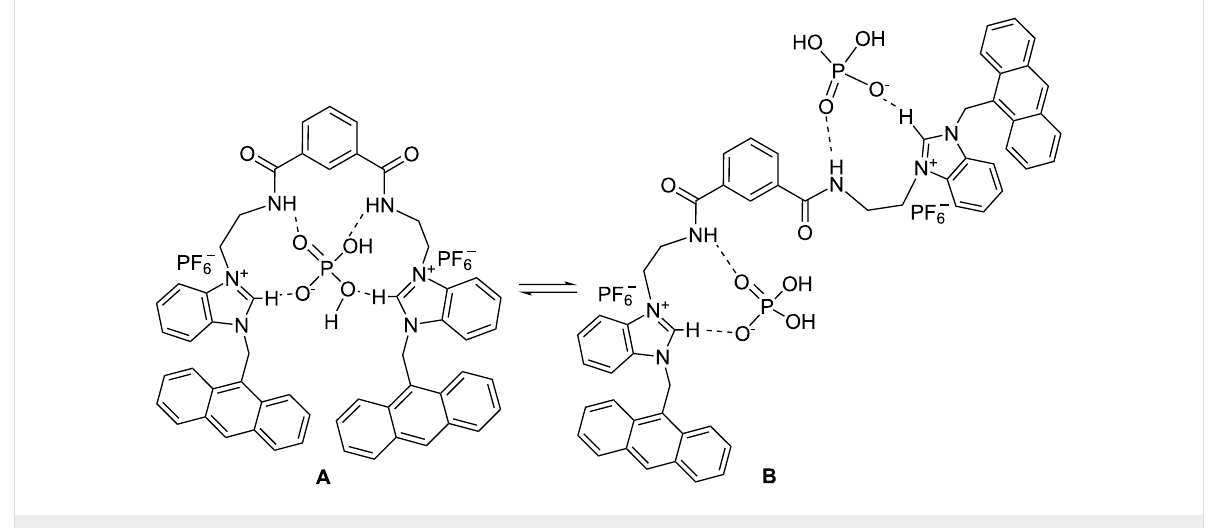
Figure 5: Suggested modes of binding of the H 2 PO 4 − ion into the cleft of 1 .